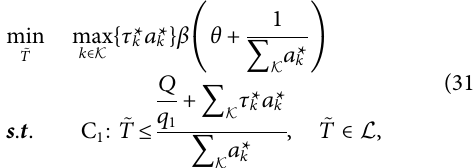
Algorithm 1. Dinkelbach ’ s Algorithm for solving (26), ∀